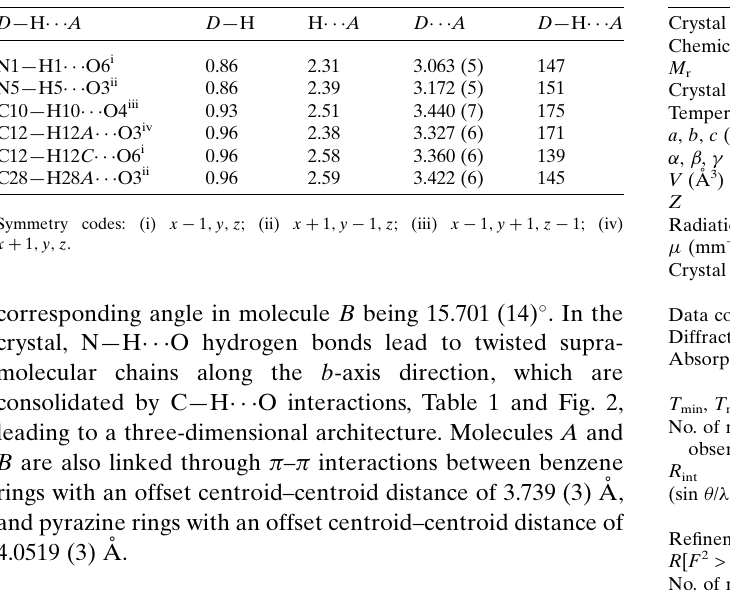
Table 2 Experimental details.